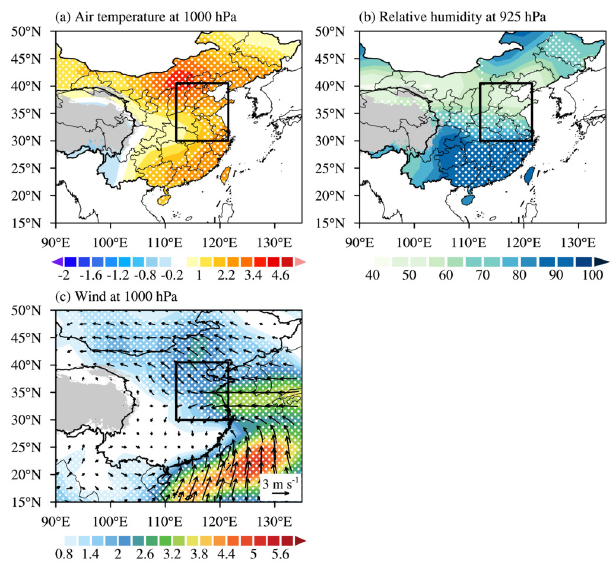
Figure 3. Composite (a) anomalous air temperature at 1000hPa, (b) absolute values of relative humidity at 925hPa, and (c) anoma- lous wind (arrows) and wind speed (shading, ms − 1 ) at 1000hPa for the 13 SR–NH events. The dotted white region indicates areas at the 99% confidence level based on the two-tailed Student t test. The black box indicates the NCP (30–40.5 ◦ N, 112–121.5 ◦ E) and the gray area is the Tibetan